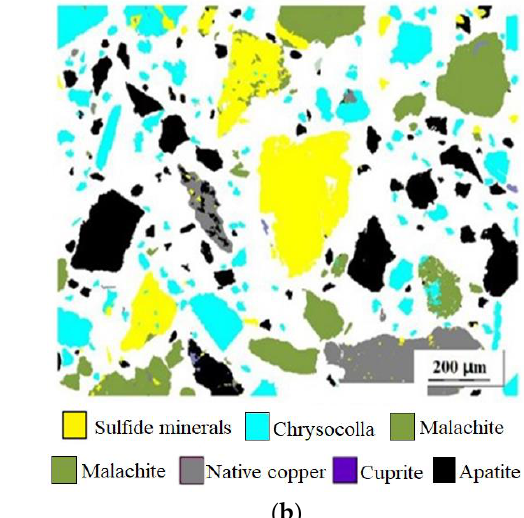
Table 5. The associated minerals of major sulfide minerals.